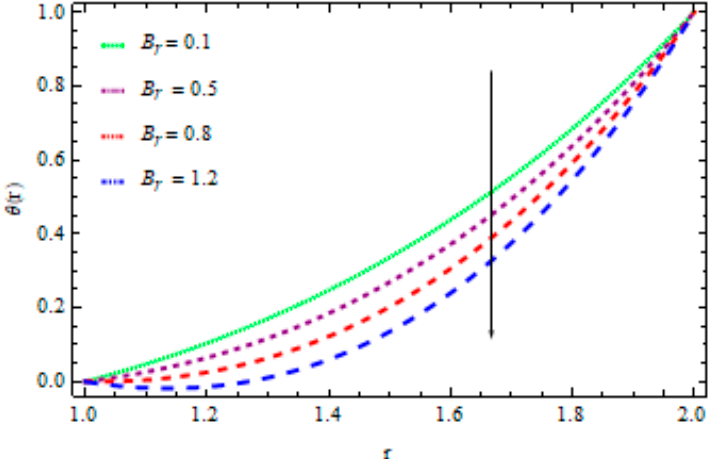
= Figure 9. The influence of B r on temperature when Q = 0.6, ε = 1.5, N = 0.2, K p =